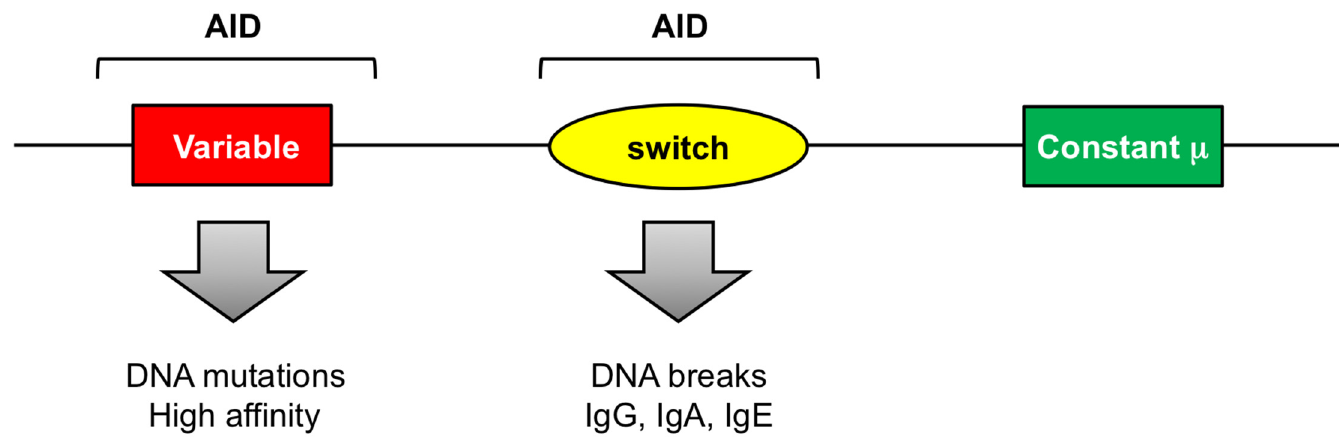
Fig 1. AID is directed to variable and switch regions on the immunoglobulin loci. Mutations in variable genes change amino acids to encode high affinity antibodies. Mutations in the switch regions preceding constant genes on the heavy chain locus cause double-strand breaks to recombine from the initial IgM to IgG, IgA, and IgE